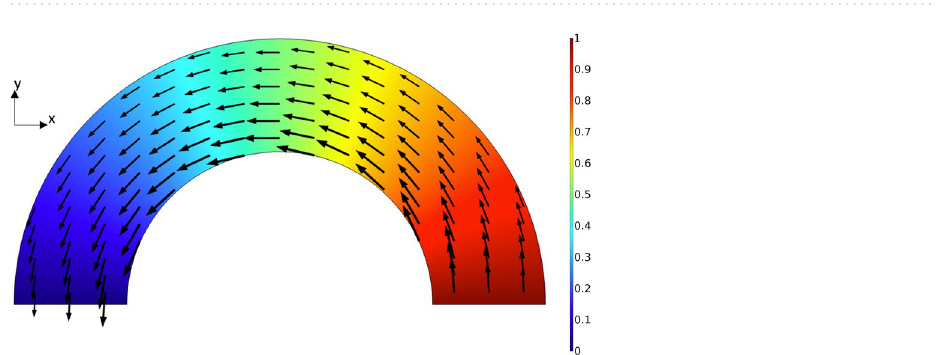
Figure 8. Simulated radiation patterns for the non-equilibrium transport arc models in the orbital plane (arbitrary scale). ( a ) The 0.5 THz system and the 1 THz system ( b ) at the design frequency (blue) and at peak emission (green). The finite element software used does not account for particle dynamics and hence does not produce the expected circular rotating dipole radiation pattern. The shape instead resembles a dipole oscillating along the x-axis.